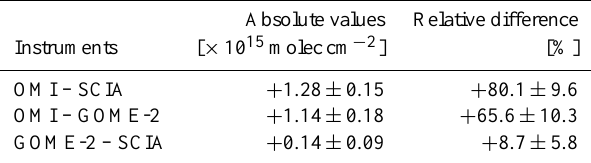
Table 2. Average differences in stratospheric NO 2 columns over the Pacific Ocean area (60 ◦ S–60 ◦ N, 140–180 ◦ W) of 2007 of OMI, GOME-2 and SCIAMACHY, where the averages are com- puted from monthly latitudinally binned data. The relative differ- ence (right column) is given as percentage of the column values of the second instrument in the difference, e.g. w.r.t. SCIA in the dif- ference OMI − SCIA (data source: http://www.temis.nl/). Absolute values Relative